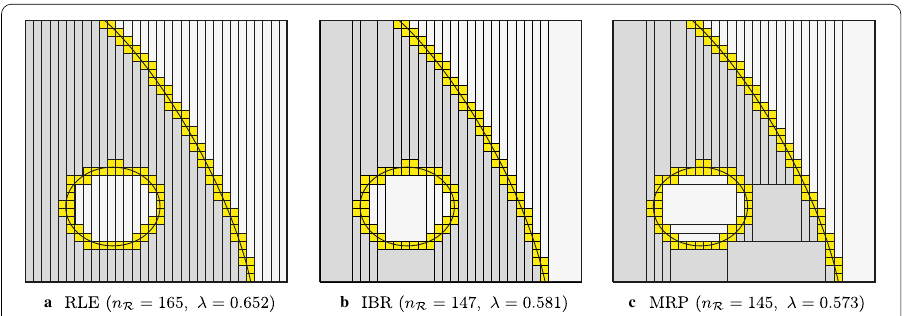
Fig. 12 Sub-cells resulting from the different compression techniques, when applied to the example depicted in Fig. 9b. Since the cut sub-cells (yellow) are not compressed, they are identical for all compression